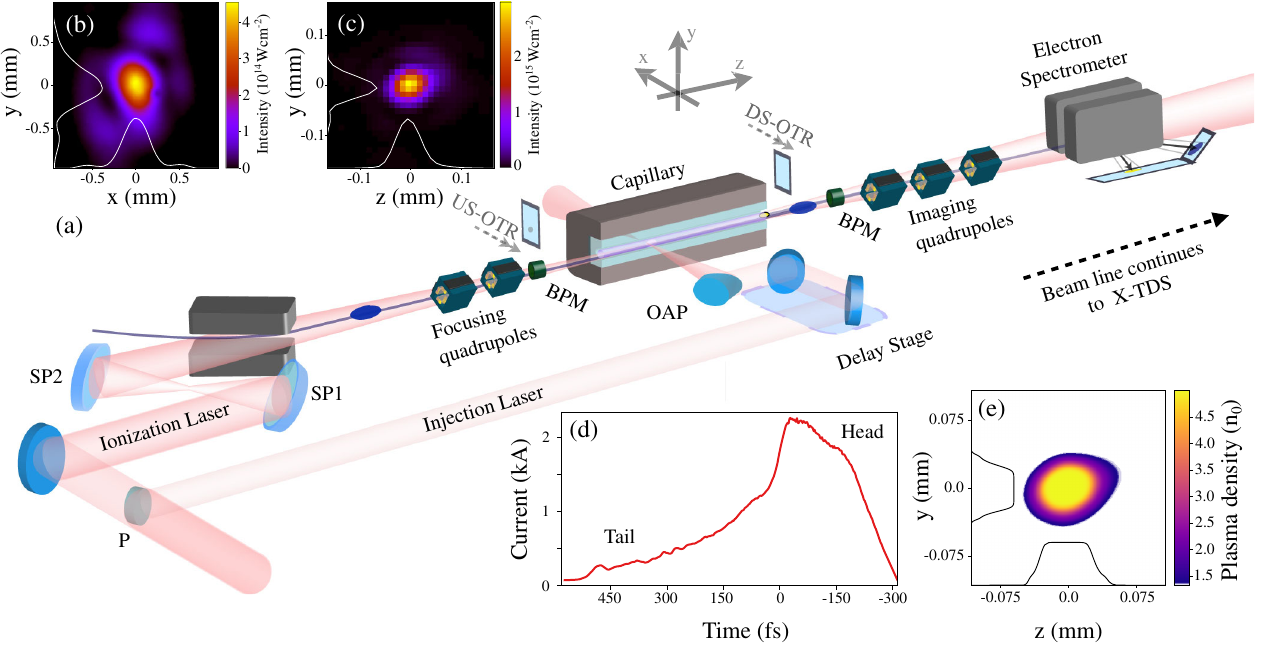
FIG. 1. Schematic layout depicting the key elements of the experimental setup at FLASHFORWARD . (a) Laser and electron beamline layout: P is the pick-off mirror for the transverse injection laser beam, SP1 and SP2 are spherical mirrors focusing the longitudinal ionization laser and OAP is the off axis parabola focusing the injection laser. The BPMs are shown; US-OTR and DS-OTR represent the upstream and downstream optical-transition-radiation screens, respectively. These can be moved into the beam path as alignment diagnostics. Foci for the (b) ionization and (c) injection lasers on the US-OTR are shown. (d) is the measured current profile of the drive beam. A side view of the plasma density calculated in the injection region from (c) is displayed in (e) (normalized to the background plasma density n e ). The plasma density is calculated from ADK ionization rates [50,51]. Black lines in (e) and white lines in (b,c) are axial